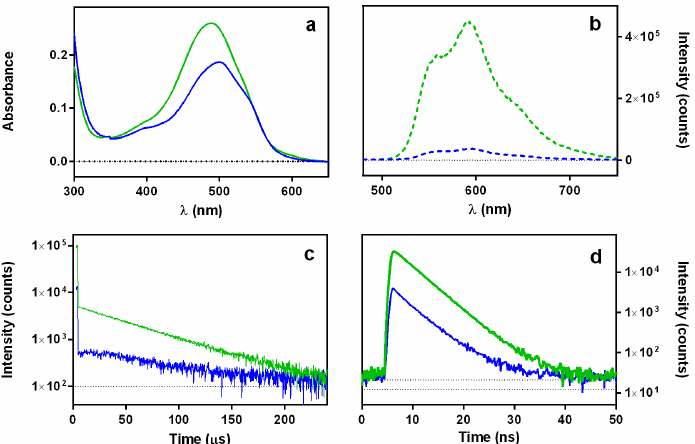
Figure 6. Spectroscopic and photophysical properties of DOXO in D 2 O solutions in the absence (green traces) and presence (blue traces) of 60 μ g/mL DNA: absorption spectra ( a ); fluorescence emission spectra ( b ); singlet oxygen phosphorescence kinetics at 1275 nm upon excitation at 473 nm ( c ); and fluorescence kinetics upon excitation at 504 nm and observation at 660 nm ( d ).